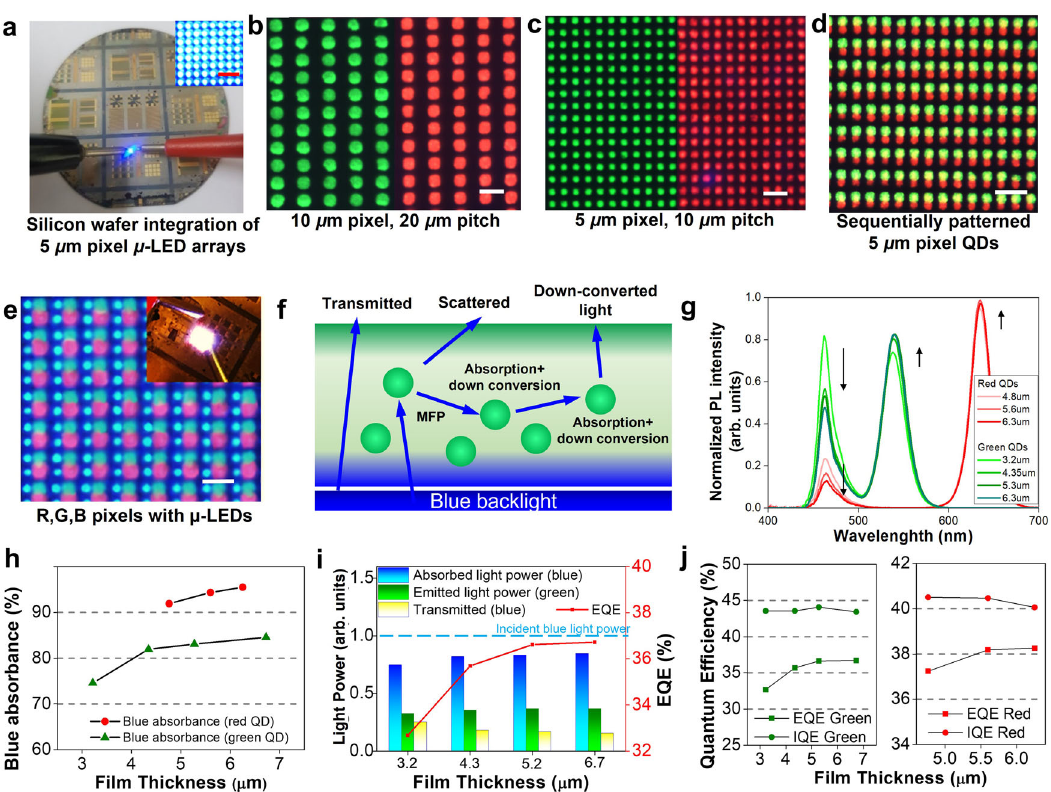
Fig. 4 Characterization of the QD-integrated full-color μ -LED display. a Photographic image of the wafer with an ultra fi ne pixel micro-LED array. b , c Microscopic images of the R/G single QD patterns under UV light with 10 and 5 μ m pixels, respectively. All scale bars denote 20 μ m. d A microscopic image of R/G double QD patterns under UV light. e A microscopic image of RGB pixels for the QD-integrated μ -LED arrays. f Schematic of the QD color conversion process. g PL spectra of the green/red QD layers. h Absorbance of the blue light from the LED as a function of QD fi lm thickness. The absorbance is measured by subtracting the transmitted blue light power from the incident blue light power. i Normalized light power intensities of the absorbed blue light, emitted green light, and transmitted blue light as a function of the green QD fi lm thickness. The EQE saturates as the QD thickness increases. j EQE and IQE as a function of the QD fi lm thickness for both green and red